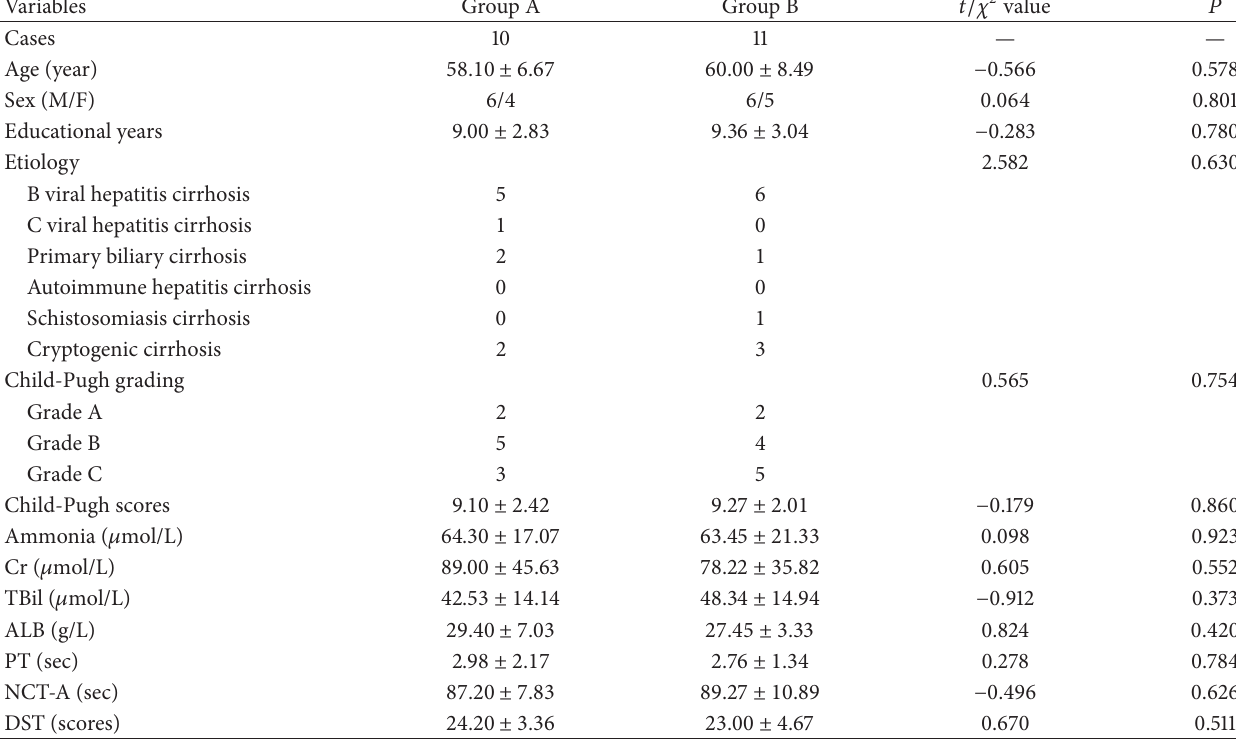
Table 3: Patient demographics and blood analysis before treatment between groups A and B.